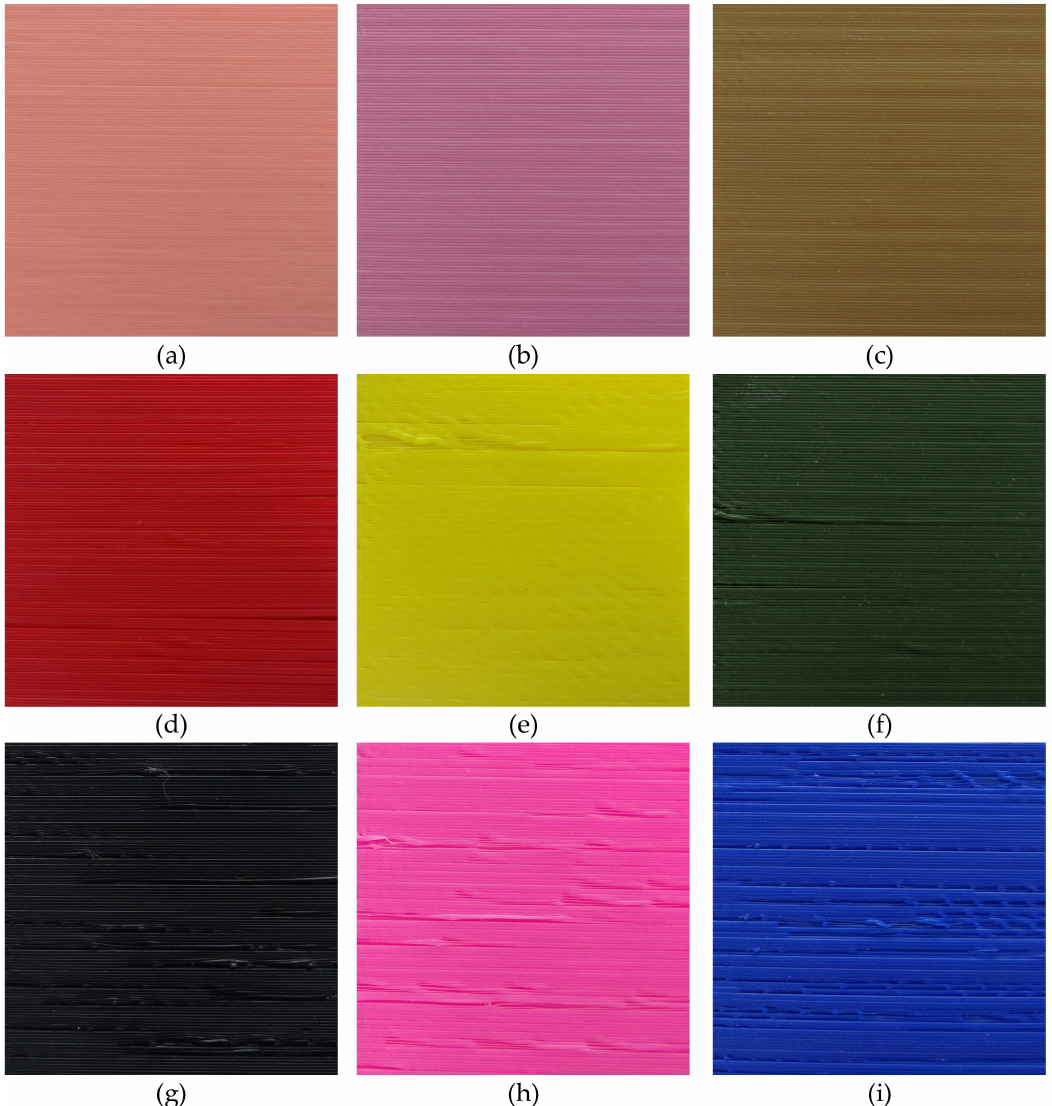
Figure 1. Sample images from the developed database with their average subjective quality scores sorted from the highest to lowest: ( a ) high quality salmon pink sample (MOS = 4.7253), ( b ) high quality pink sample (MOS = 4.6923), ( c ) high quality brown sample (MOS = 4.1333), ( d ) moderately high quality red sample (MOS = 2.4130), ( e ) moderately low quality yellow sample (MOS = 1.4130), ( f ) low quality dark green sample (MOS = 1.1868), ( g ) low quality black sample (MOS = 1.0978), ( h ) low quality fluorescent pink sample (MOS = 1.0110), ( i ) low quality blue sample (MOS =